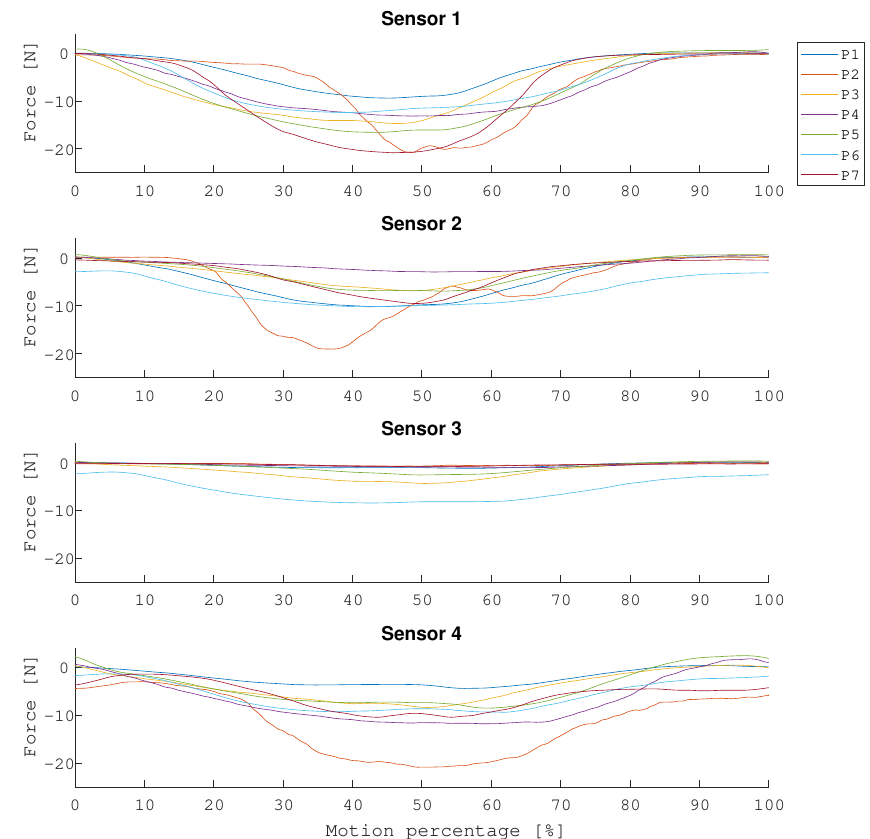
Figure 12. The pressure readings of each pressure sensor during the entire motion is shown. The pressure values that are shown are the average values across all